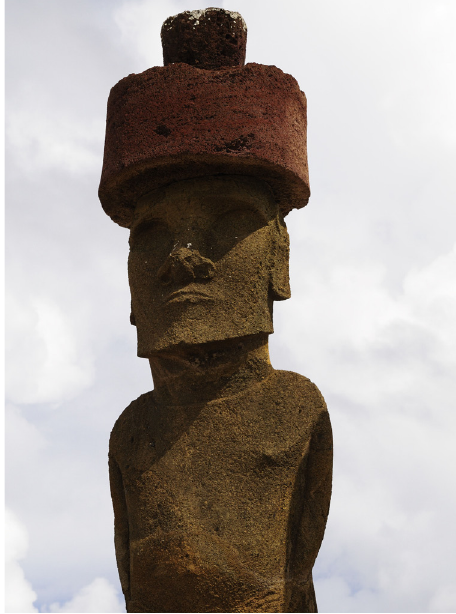
Fig. 7: Detail of a Rano Raraku statue at Ahu Nau Nau, showing eye sockets and pukao ‘hat’ (photo: A.